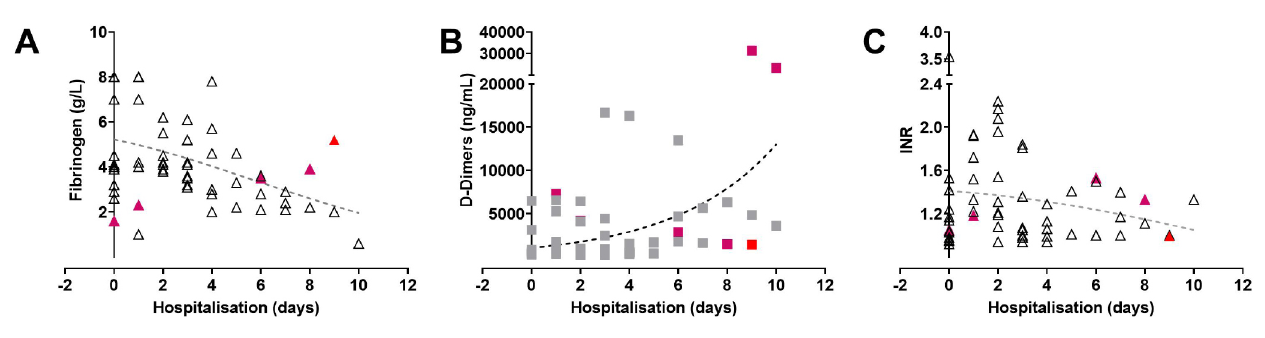
Fig. 5 - Analysis of coagulation markers. Patients receive an initial 25000 international units (IU) bolus injection (≈ 300 IU/kg) followed by continuous infusion of 300 IU/kg dissolved in physiological buffer (0.9% sodium chloride) administered at 6–8 mL/h flow rate; target activation clotting time ≥ 200 s during hospitalisation. Patients' coagulation statuses were tracked by evaluating fibrinogen, D-Dimers, and the international normalised ratio (INR). The coloured (red #1) (purple #2) symbols show the values for the two mortality